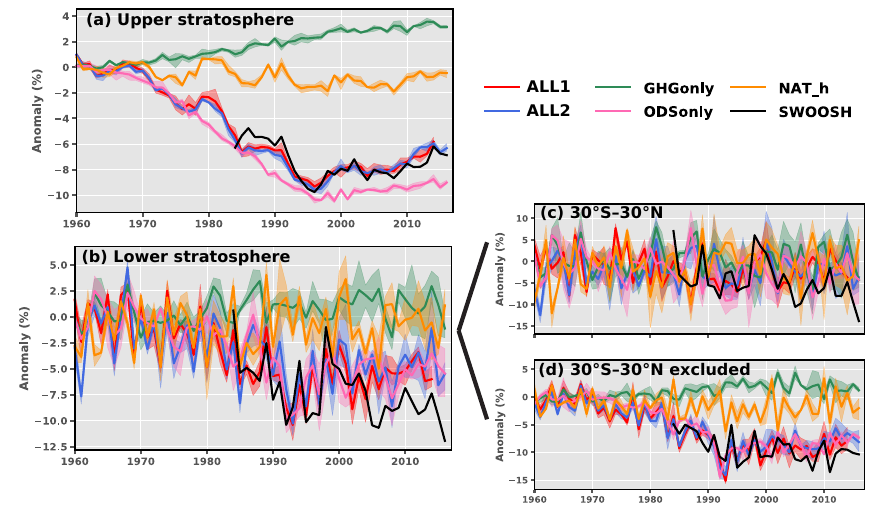
Figure 1. Time series of global mean annual ozone anomalies for (a) the upper stratosphere (1–10hPa) and (b) the lower stratosphere (40– 100hPa). The right panels show the lower stratosphere for (c) the tropics (30 ◦ S to 30 ◦ N) and (d) tropics excluded. Annual anomalies were calculated from monthly-mean model output and the SWOOSH ozone data set, and both were weighted by latitude and pressure. All model anomalies are shown as percent differences from the base years of 1960 to 1969 in ALL1. For model simulations, the spread shows the upper and lower bounds of all ensemble members. The SWOOSH record spans the period from 1984 to 2016 and the anomalies were also defined as percent differences from the base years of 1960 to 1969 in the ALL1 simulation.